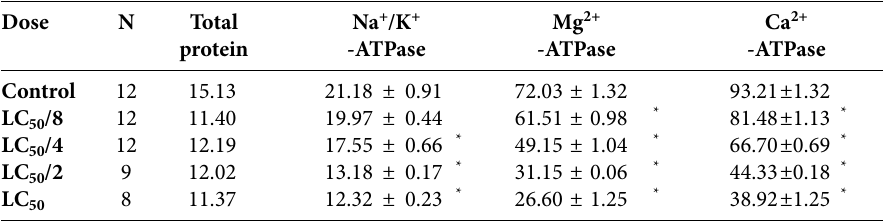
Table 5. Biochemical responses of 96-h Thmx exposure in muscle. Total protein amount expressed as mg ml –1 , and enzyme activities expressed as µmol P i min –1 mg protein –1 ± mean standard error. Dose N Total Na + /K + Mg 2+